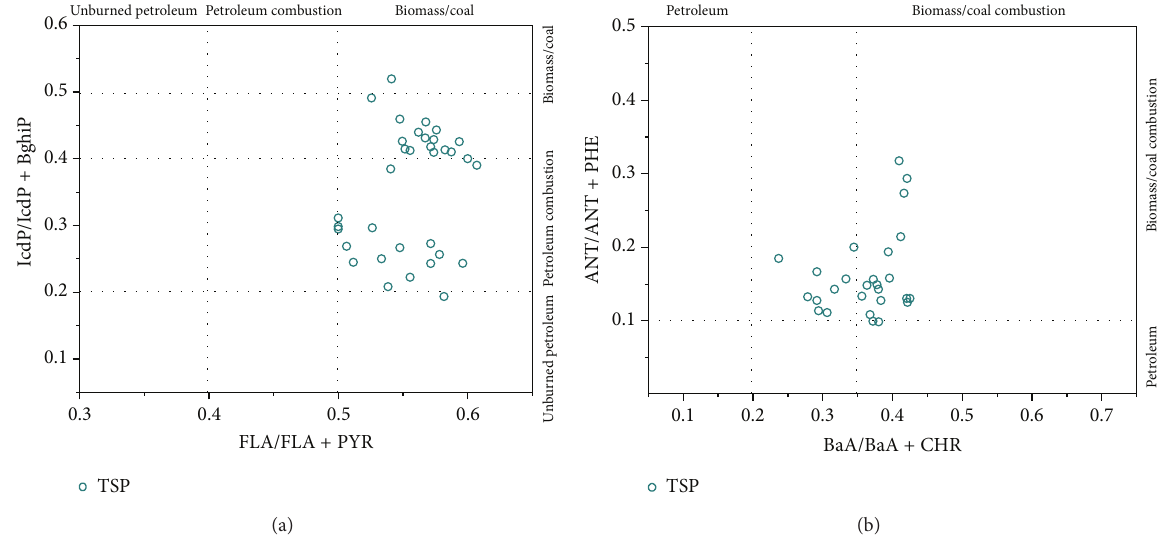
Figure 4: Diagnostic PAH ratios for TSP samples collected at Mount